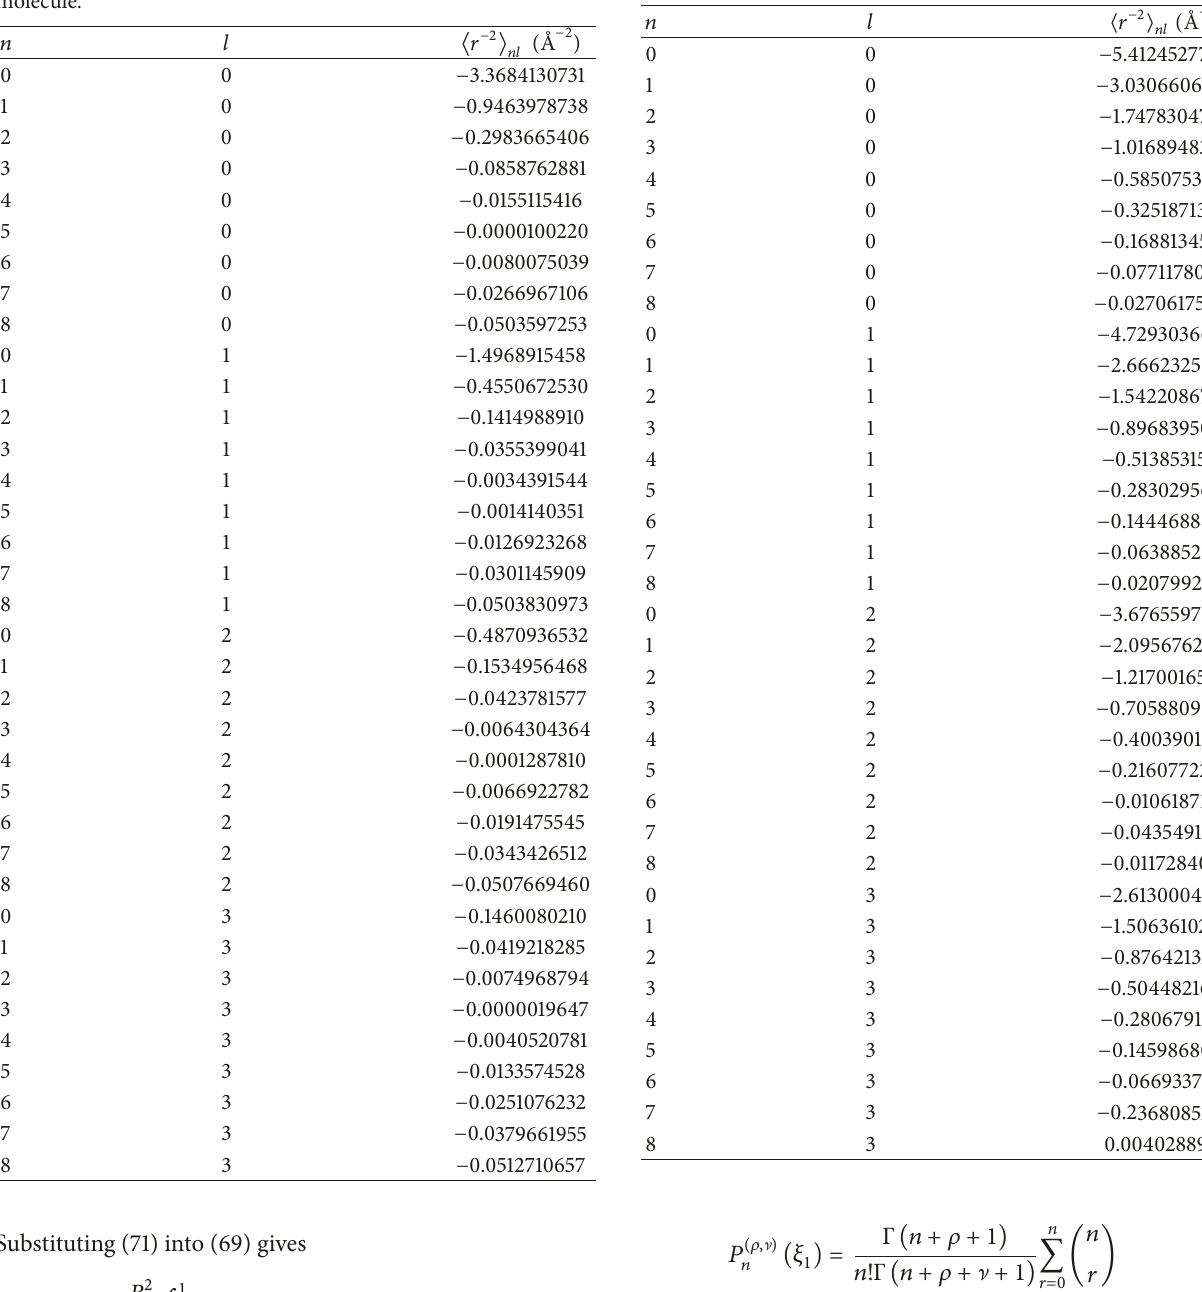
Table 5: Expectation values of ⟨𝑟 −2 ⟩ for carbon ( 11 ) oxide